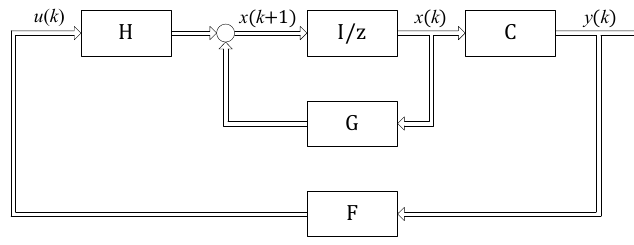
Figure 4. Output feedback control.